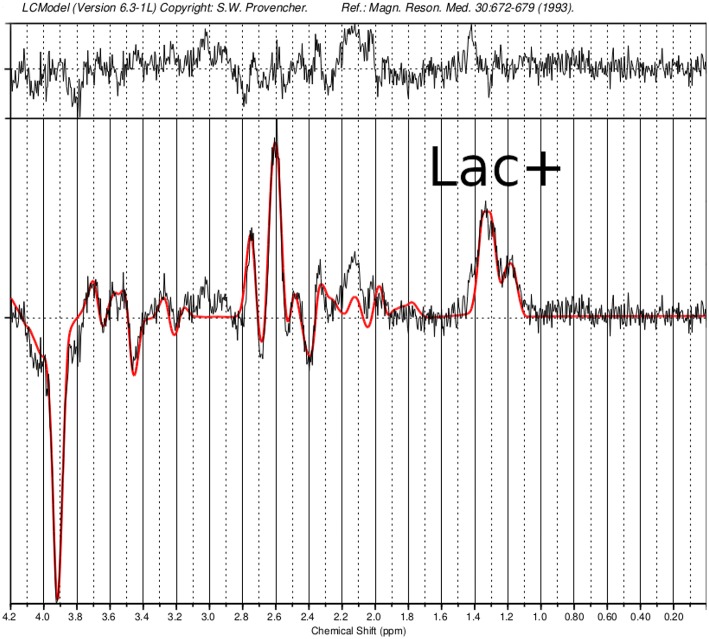
Single-voxel magnetic resonance spectroscopy imaging. Presented is a MEGA-sLASER difference spectrum from the orbitofrontal cortex (OFC) of the patient, with indicated lactate (Lac)+ resonance. In the OFC, a Lac+/Creatine concentration ratio of 0.182 was found compared to a control group (N=6; 5 males and 1 female; 28 ± 2 years) with 0.159 ± 0.01.